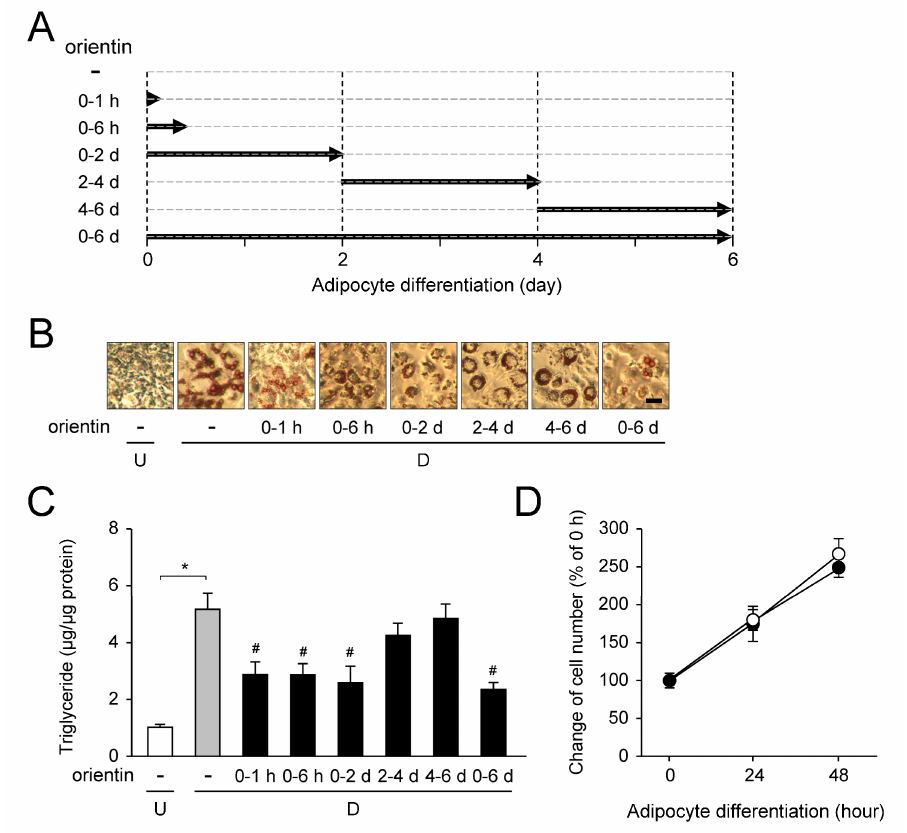
Figure 7. Stage-specific effect of orientin in adipocyte differentiation. ( A ) Addition of orientin at the distinct time periods; 0–1 h (0–1 h), 0–6 h (0–6 h), 0–2 days (0–2 d), 2–4 days (2–4 d), 4–6 days (4–6 d), or 0–6 days (0–6 d) during the 6-days-adipogenesis; ( B ) Oil Red O-stained intracellular lipids in medium with stage-specific addition of orientin. 3T3-L1 cells (undifferentiated cells: U; white column) were allowed to differentiate into adipocytes (differentiated cells: D) for 6 days in the absence (gray column) or presence (50 µ M; black columns) of orientin. Bar = 50 µ m; ( C ) Intracellular TG level. 3T3-L1 cells were differentiated as described in the legend of Figure 7B. Data are the means ± S.D. from three experiments. * p < 0.01, as shown by the brackets. # p < 0.01, as compared with the vehicle-treated differentiated cells (gray column); ( D ) Effect of orientin to mitotic clonal expansion. Confluent 3T3-LI preadipocytes were differentiated in medium without (closed circles) or with orientin (50 µ M; open circles) for 48 h. Cell number was counted by Cell Counter. The data are shown as the means ± S.D. from three